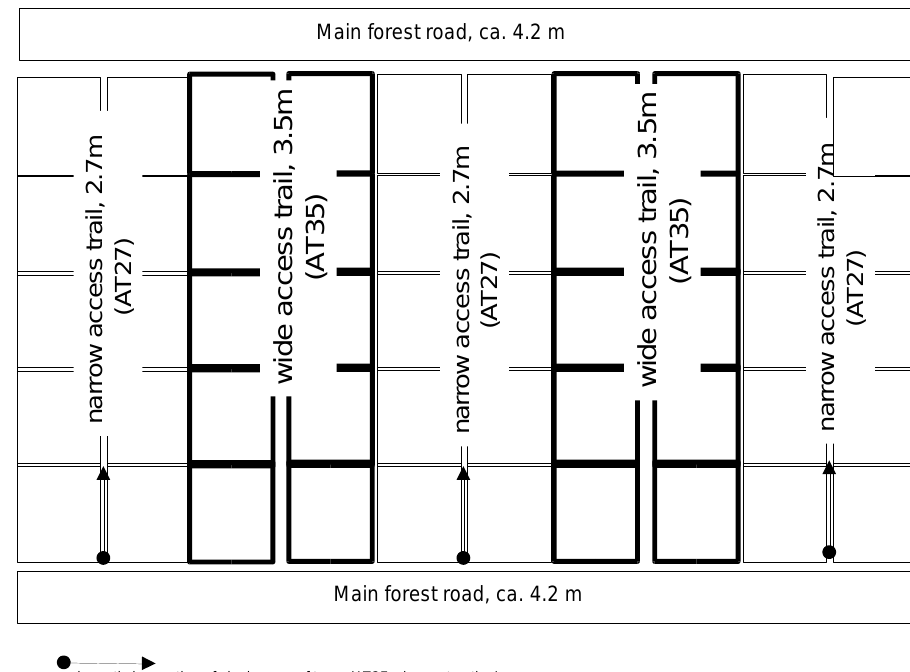
schematic harvesting of single rows of trees (AT27schemextraction) Figure 1. Scheme of sample plot location. Figure 1. Scheme of sample plot location. Table 2. Summary of stand